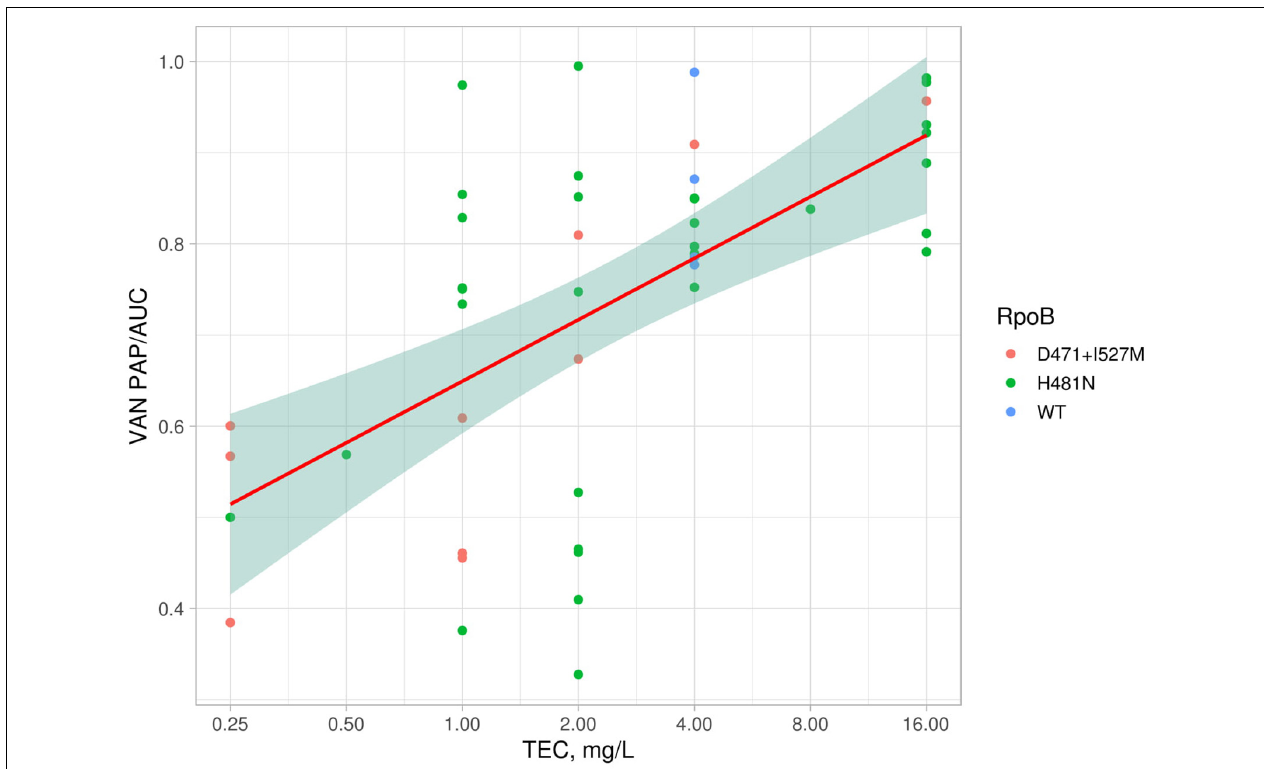
FIGURE 7 | Linear model and confidence interval plot with PAP/AUC data and teicoplanin MICs. Each point represented by AAS in RpoB (WT—wild